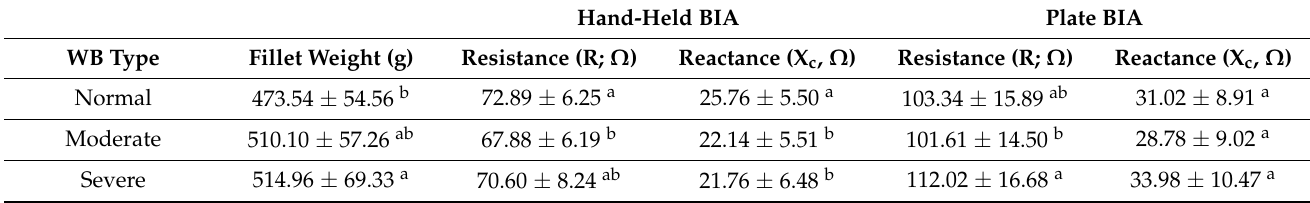
Table 1. Summary table for two different bioelectrical impedance device setups for resistance, reactance and fillet weights among woody chicken breast fillets with varying severity